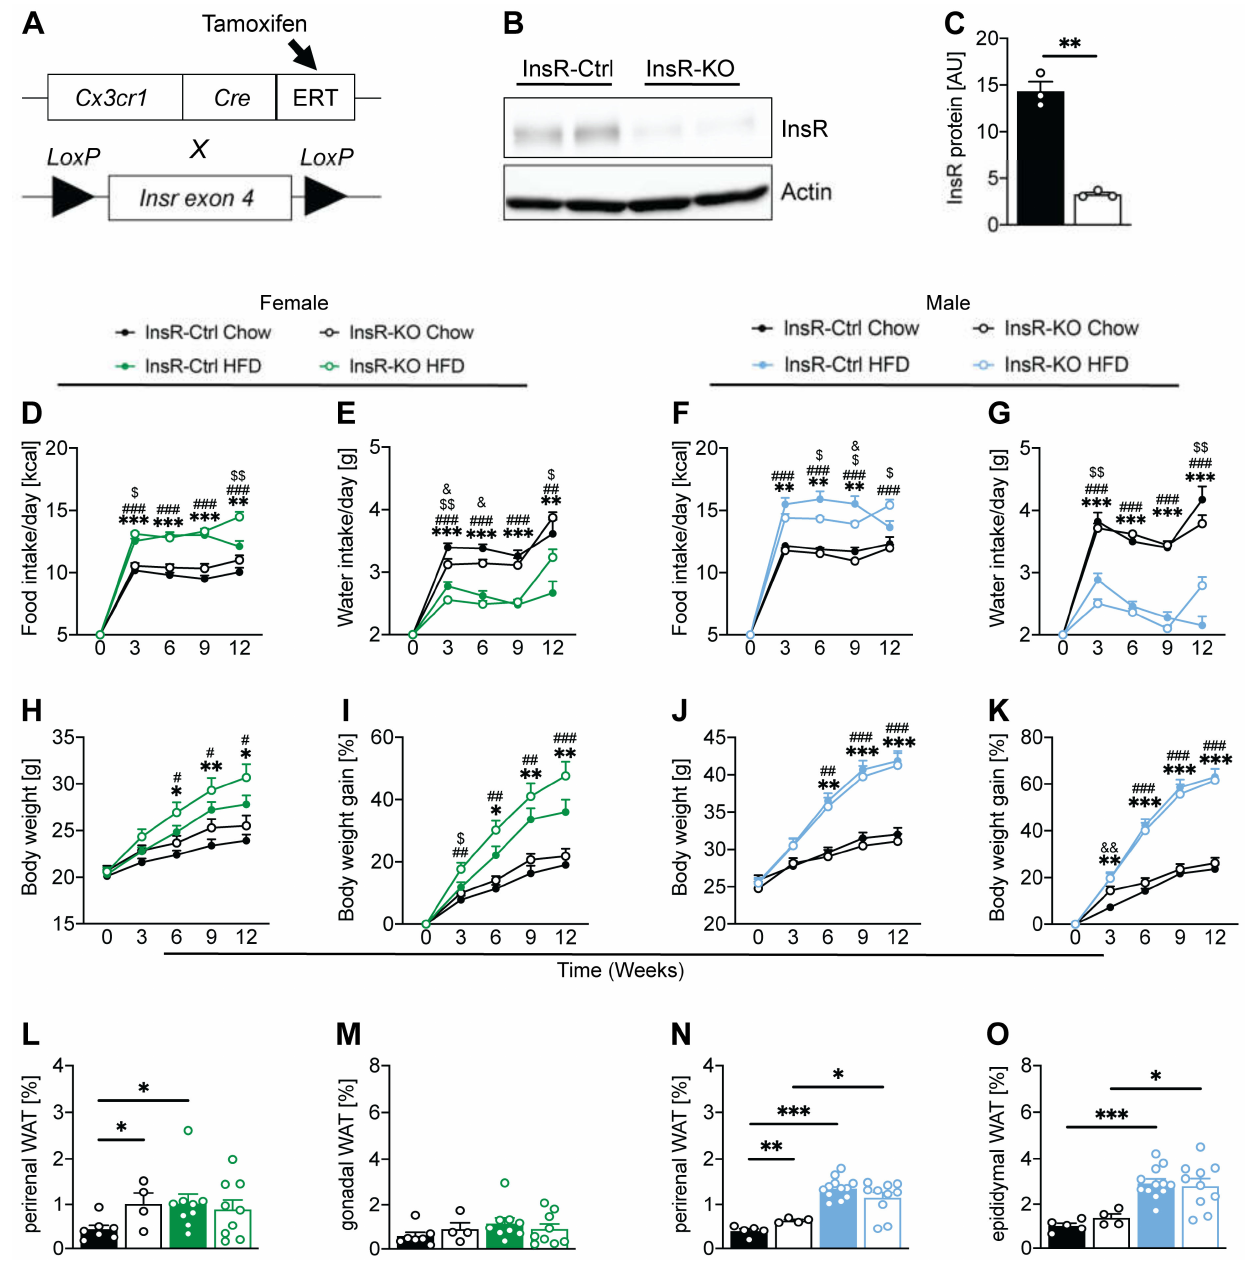
Figure 1. Lack of microglial InsR alters the phenotypic progression of obesity in both male and female mice. ( A ) Schematic representation of the Cre/loxP animal model used in this study. ( B ) Western blot and ( C ) quantification of InsR in primary microglia of InsR-Ctrl ( n = 3) and InsR-KO ( n = 3) mice, following 4-hydroxytamoxifen treatment. There was a significant decrease of InsR protein in InsR-KO microglia, compared to InsR-Ctrl microglia; ( D , E ) Female InsR-Ctrl and InsR-KO mice fed a Chow (black) or HFD (green) data for ( D ) food intake and ( E ) water intake during 12 weeks of diet exposure ( n = 10–25); ( F , G ) Male InsR-Ctrl and InsR-KO mice fed a Chow (black) or HFD (blue) data for ( F ) food intake and ( G ) water intake during 12 weeks of diet exposure ( n = 16–27). Female HFD-fed InsR-KOs had higher caloric intake after 3 weeks of HFD, compared to InsR-Ctrls, while male InsR-KO had lower caloric intake after 6 and 9 weeks of HFD, compared to InsR-Ctrls; ( H , I ) Female InsR-Ctrl and InsR-KO mice fed a Chow diet (black) or HFD (green) data for ( H ) body weight and ( I ) body weight gain presented in percentage, during 12 weeks of diet exposure ( n = 10–25); ( J , K ) Male InsR-Ctrl